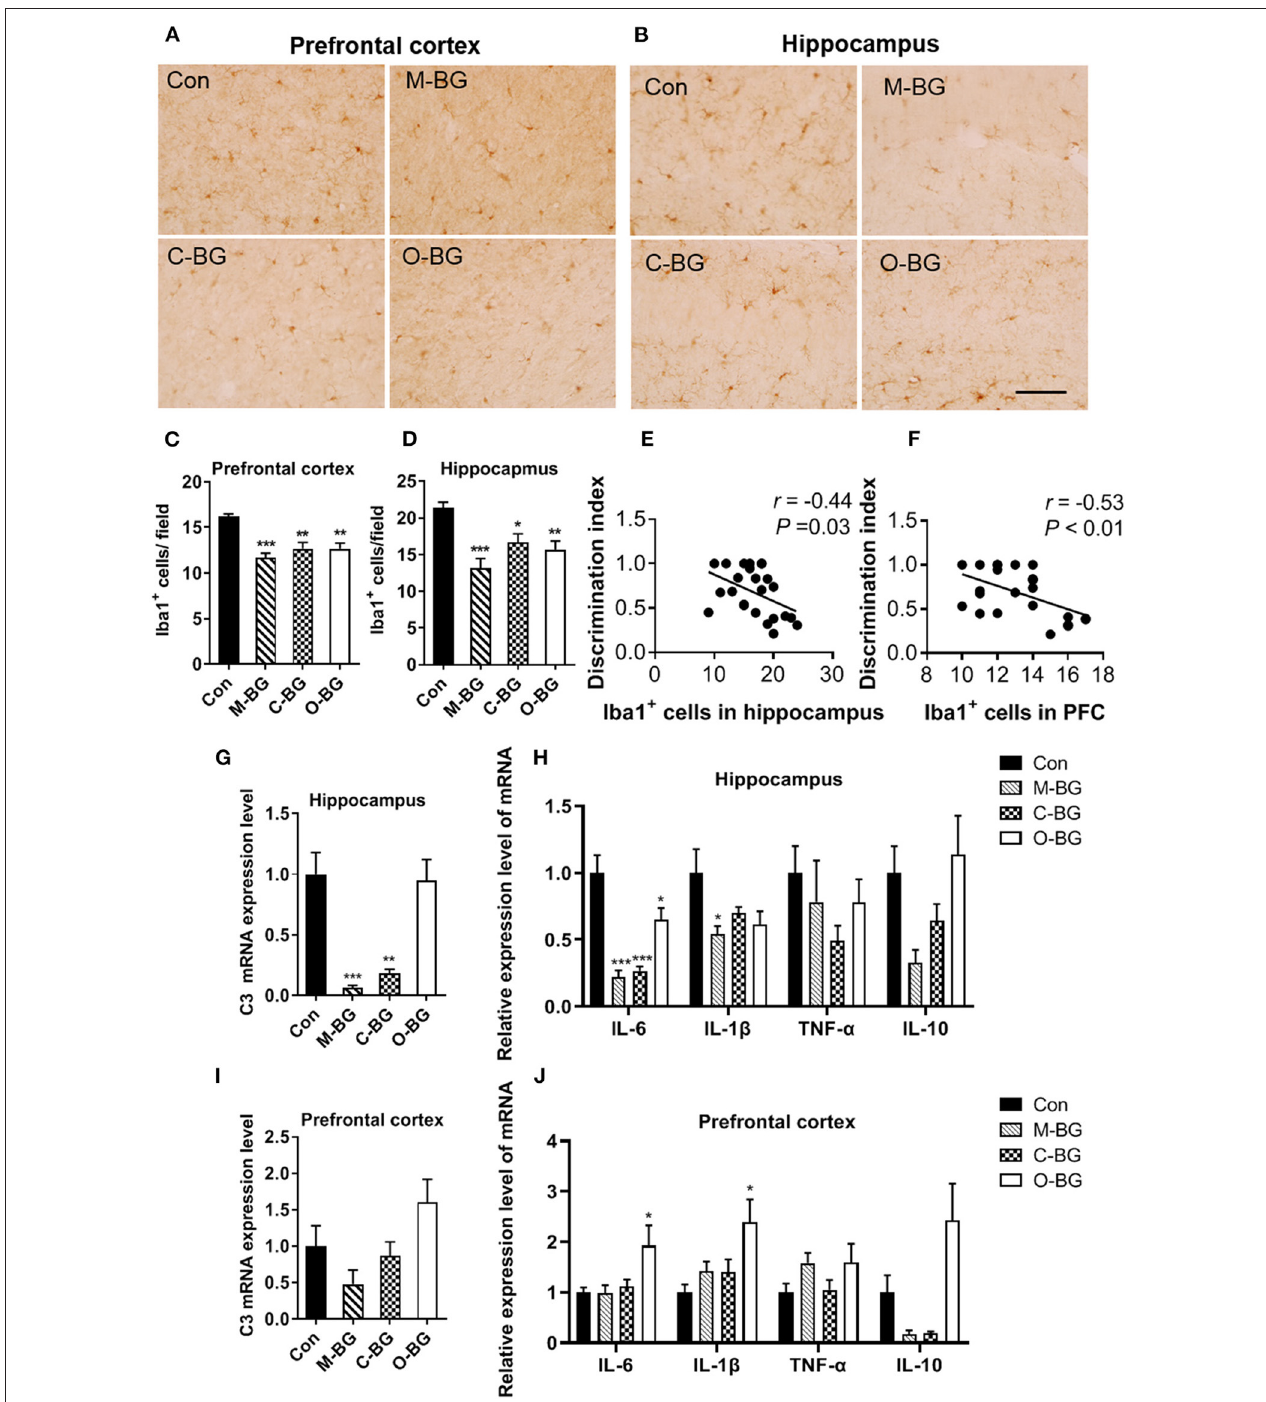
FIGURE 2 | Effects of dietary β -glucans on microgliosis and neuroinflammation of mice. (A) Immunohistochemical staining of Iba1 positive cells in the PFC of mice, n = 6. (B) Immunohistochemical staining of Iba1 positive cells in the hippocampus of mice, n = 6. (C) Quantification of Iba1 positive cells in the PFC of mice. (D) Quantification of Iba1 positive cells in the hippocampus of mice. (E) Pearson’s correlation analysis between Iba1 positive cells in the hippocampus and discrimination index. (F) Pearson’s correlation analysis between Iba1 positive cells in the PFC and discrimination index. (G) mRNA expression of C3 in the hippocampus of mice, n = 6. (H) mRNA expression of IL-6, IL-1 β , TNF- α , and IL-10 in the hippocampus of mice, n = 6. (I) mRNA expression of C3 in the PFC of mice, n = 5–6. (J) mRNA expression of IL-6, IL-1 β , TNF- α , and IL-10 in the PFC of mice, n = 6. Data were presented as mean ± SEM. * P < 0.05 vs. Control, ** P < 0.01 vs. Control, *** P < 0.001 vs. Control. Scale bar: 40 µ m.